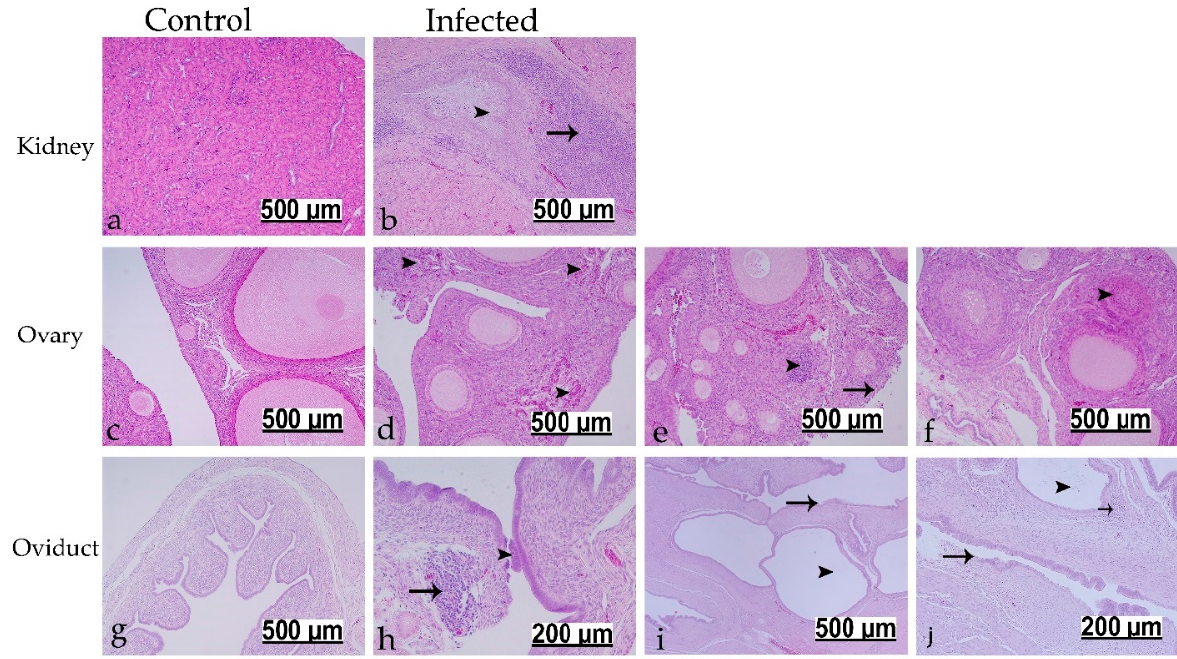
Figure 7. Histopathological changes detected in kidney, ovary, and oviduct at 112 dpi following infection at 1-day of age. ( a , c , g ) are controls. ( b ) Black arrowhead indicates intra-luminal mucus accumulations; black arrow shows massive mononuclear cells at lamina propria. ( d ) Black arrowheads show multi-focal heterophilic infiltrations. ( e ) Black arrowhead refers to focal mononuclear cell infiltration; black arrow refers to necrosis and sloughing of ovarian covering epithelium. ( f ) Black arrowhead indicates follicle undergoes obliterative follicular atresia. ( h ) Black arrowhead refers to sloughed epithelium; black arrow shows focal mononuclear cell aggregates. ( i , j ) Black arrowheads reveal cystic dilated glands; black arrows show sloughed epithelium; short black arrow refers to mononuclear cells.